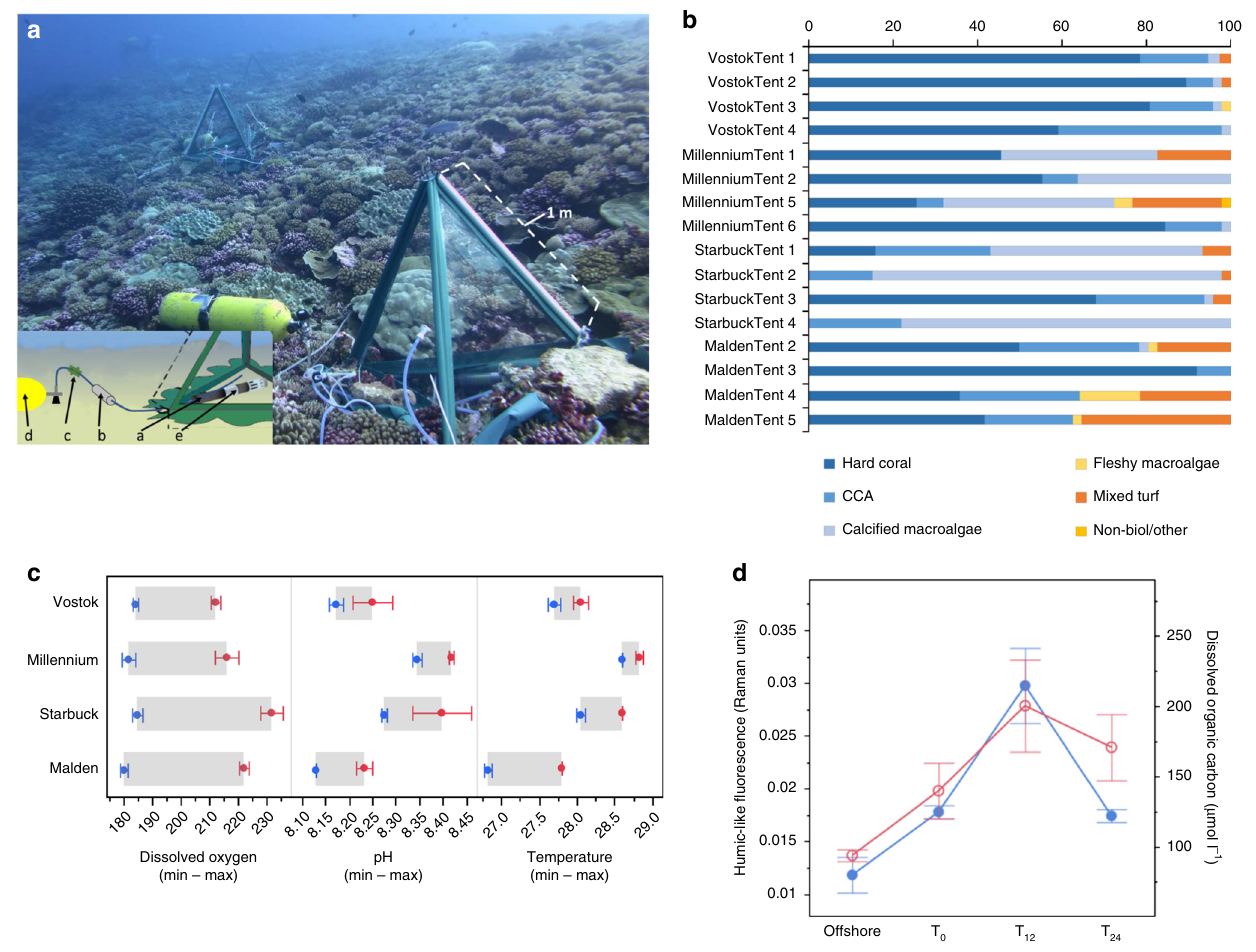
Fig. 1 Diel sampling design and reef site properties. a Collapsible benthic isolation tents (cBIT) were equipped with an autonomous night sampling mechanism. Microbial communities were collected via negative pressure through silicone tubing (a) onto a 0.22 µ m Sterivex fi lter (b). Temporal sampling was triggered by an in-line time-release valve (c) preceding a steel tank that provided vacuum pressure (d). All benthic chambers included a multiparameter sonde (e) to continuously monitor temperature, speci fi c conductivity, dissolved oxygen, and pH. Photo credit: Jennifer Smith. b Percent cover of benthic assemblages at each reef site. c Geochemical measurements for a 24-h diel period (boxes represent the mean ± SD from all four islands for the minimum (Min) and maximum (Max) of each analyte, N = 16); dissolved oxygen ( µ moleskg − 1 ); Temperature °C. d Dissolved organic carbon (DOC) concentrations (right-hand y -axis; µ moles l − 1 and humic-like fl uorescent dissolved organic matter (fDOM; left-hand y -axis; Raman units) measured in the water column offshore and within each benthic chamber on the forereef at three time-points (points represent the mean ± s.d. from all four islands, N